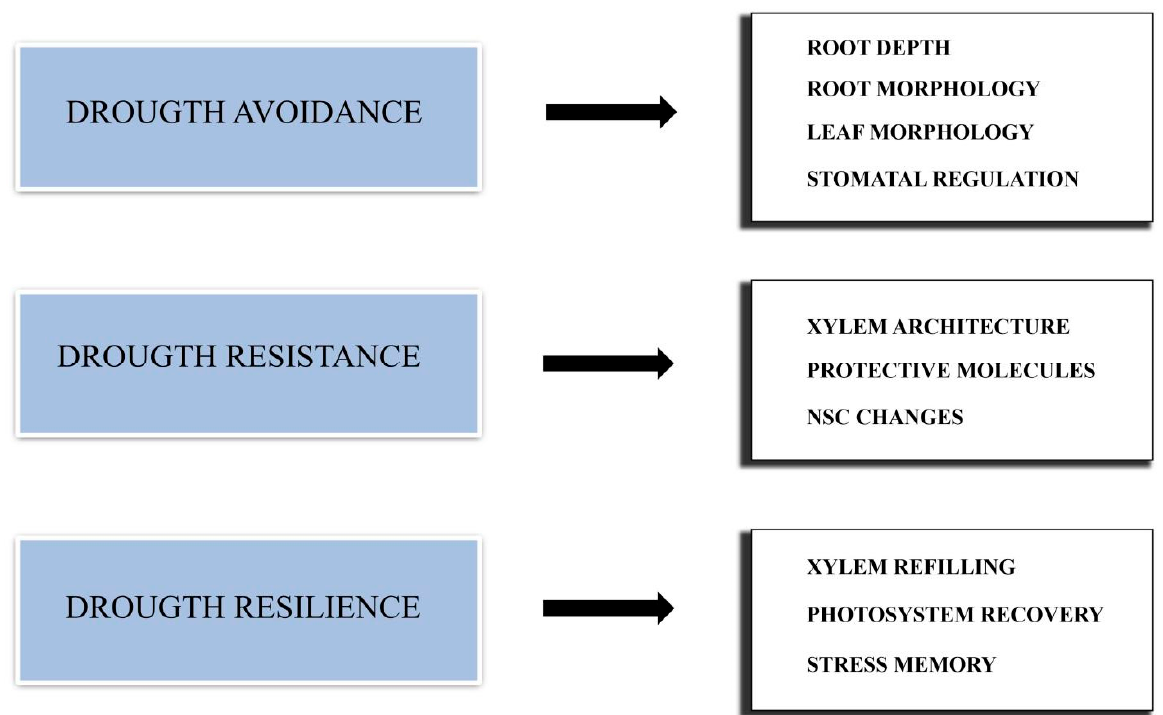
Figure 1. Schematic representation of the main strategies adopted by conifers to cope with drought stress.